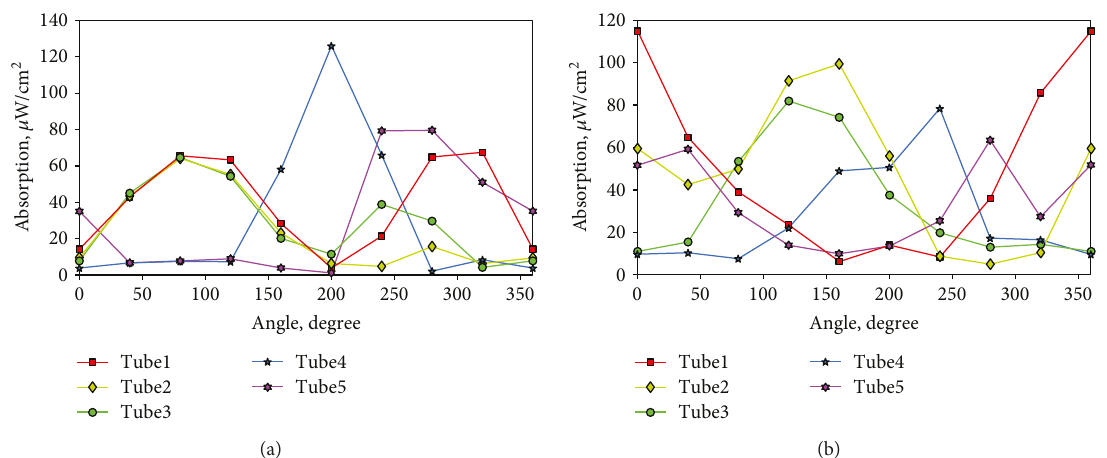
Figure 6: Power fl ux absorption distribution for the 5 tubes in con fi guration 2. June 21st at 13:00 hours. Beam (a) and di ff use (b) radiation contributions.